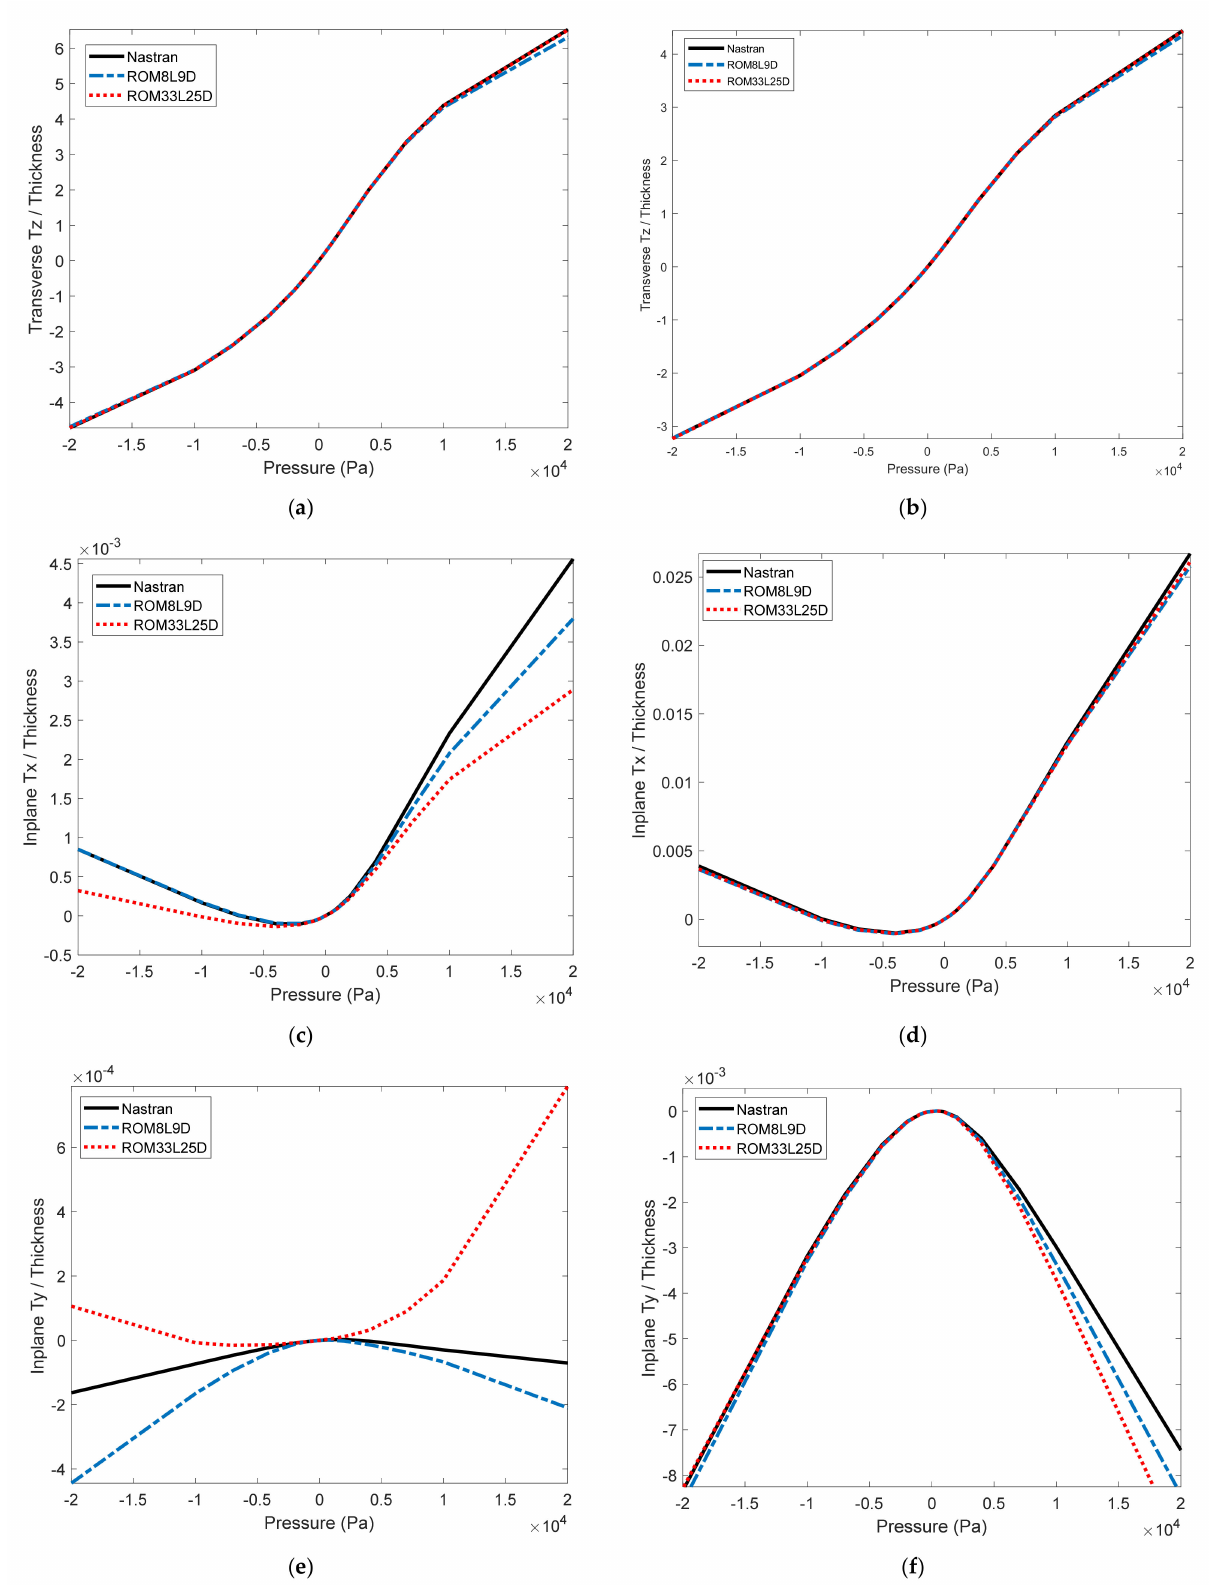
Figure 13. Static displacements induced by a uniform pressure on the orthogrid panel. Predic- tions from Nastran and the 8L9D and 33L25D ROMs. ( a , c , e ) center point, ( b , d , f ) quarter point, displacements along ( a , b ) transverse z , ( c , d ) in-plane x , ( e , f ) in-plane y